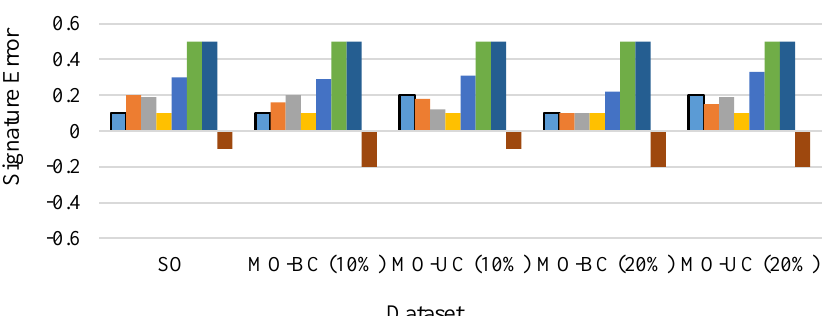
Figure 19. FMS (FDC) errors based on observations and simulations of five datasets using two main calibration approaches (SO & 4 algorithms parameterization of MO-SB).